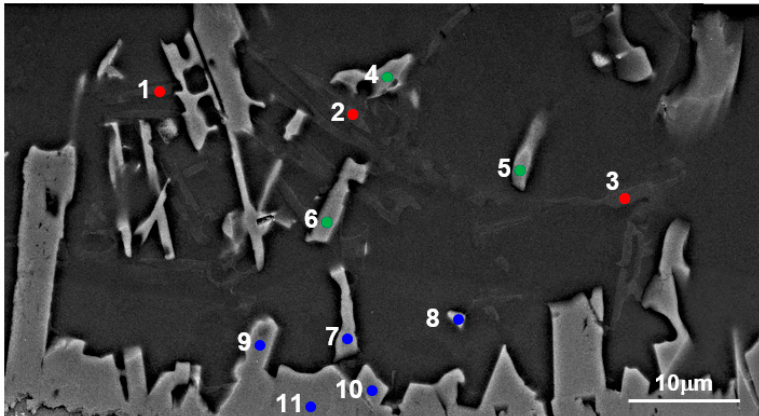
Figure 2. SEM image showing microstructure of area denoted as a rectangle "A" in Figure 1.